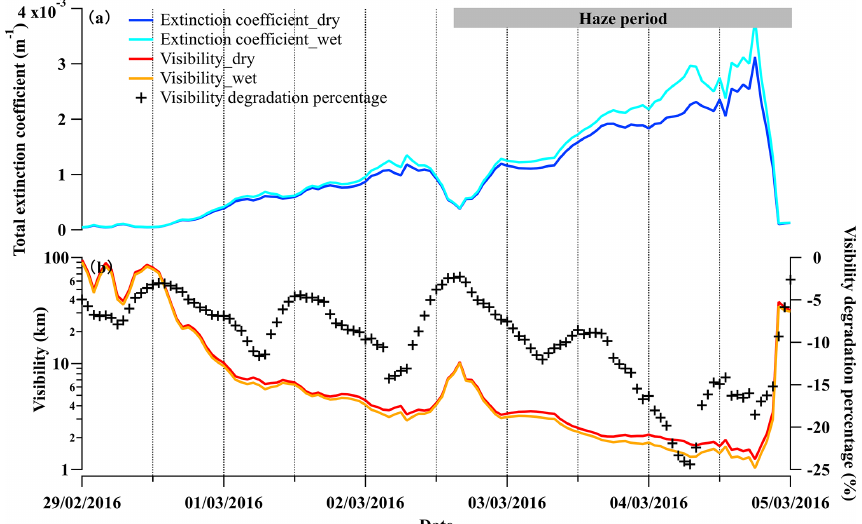
Figure 7. The time series of (a) the calculated total extinction coefficient at a wavelength of 550nm with the consideration of dry and wet PNSD, referred to as Extinction coefficient_dry and Extinction coefficient_wet and (b) calculated visibility with the consideration of dry and wet PNSD, referred to as Visibility_dry and Visibility_wet, respectively, during 29 February to 5 March 2016. The visibility degradation percentage is (Visibility_wet − Visibility_dry) / Visibility_dry, representing the visibility degradation in the presence of liquid water.